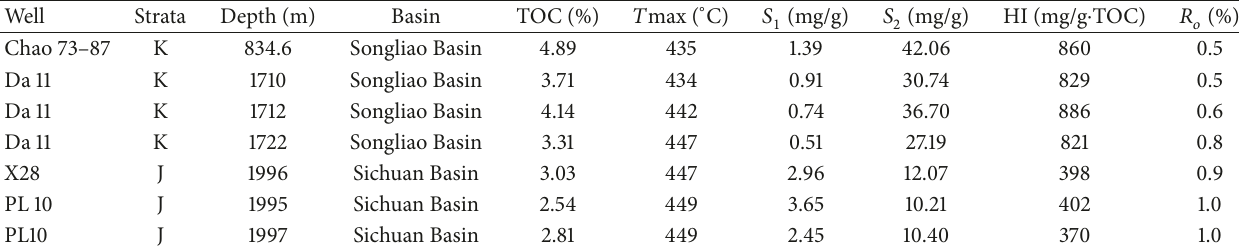
Table 1: Basic geochemical characteristics of source rock samples.